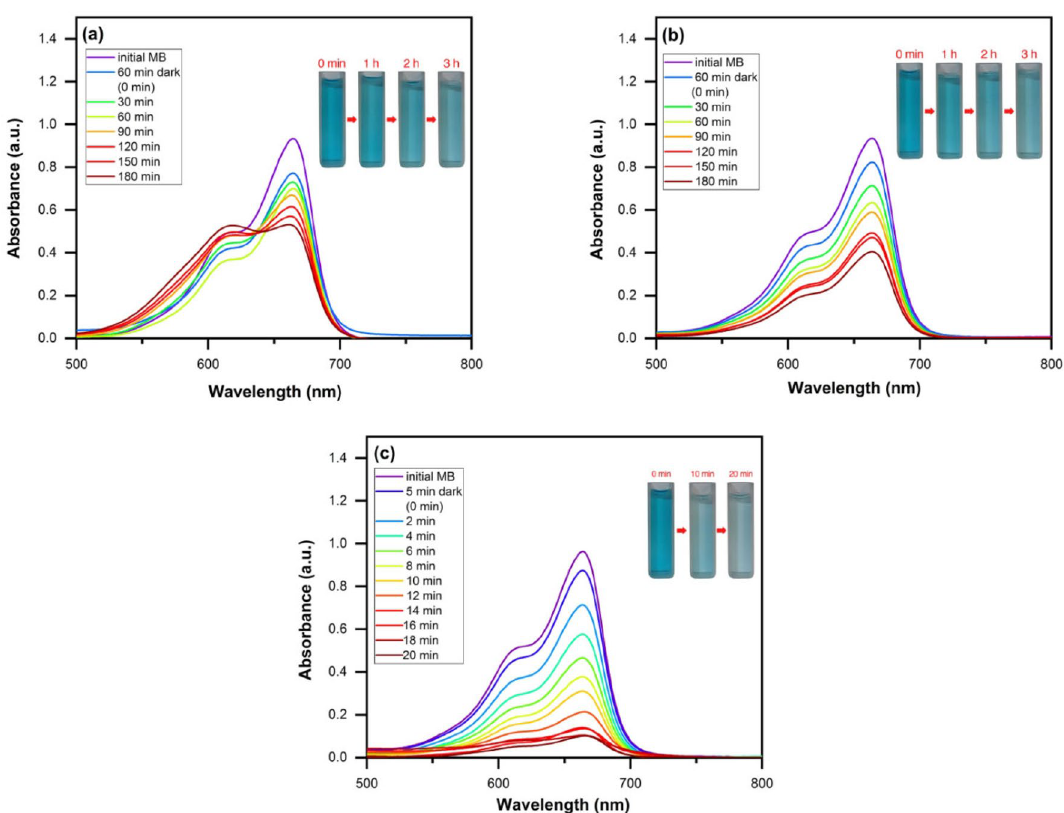
Figure 11. The absorption spectra of UV–Vis for MB dye adsorption by ( a ) ZnO nanoparticles, ( b ) ZnO/ Chitosan and ( c )